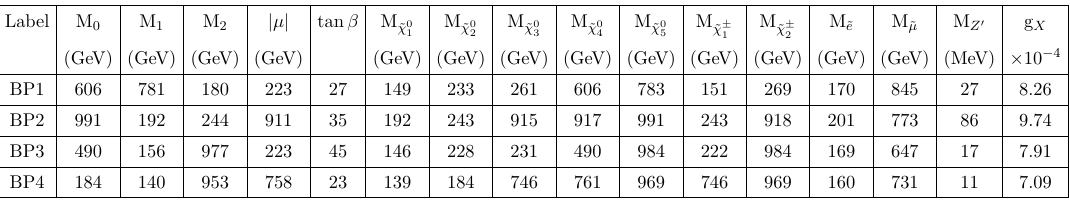
Table 3. Sample benchmark points representing four different classes of allowed parameter choices. binned in the selectron mass and the second to first generation slepton mass